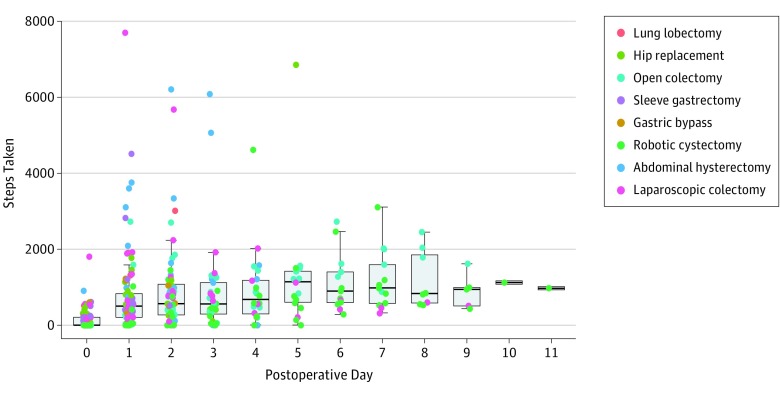
Digitally Monitored Step Count by Postoperative Day Across All Surgical ProceduresBoxes show the first quartile (lower border of the box), median (thick horizontal line within the box), and third quartile (top border of the box). Whiskers extending from the top and bottom borders of the box show the range of nonoutlier values. The individual points outside the whisker boundaries indicate outlier values that are less than the first quartile or greater than the third quartile by 1.5 times the interquartile range.